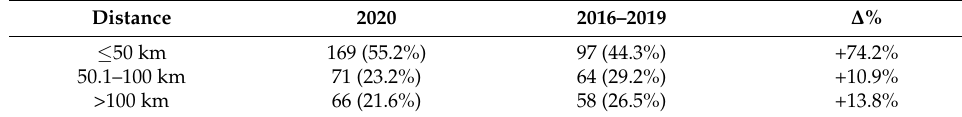
Table 7. Frequency of rescues and distance to the nearest town with over 100,000 people.